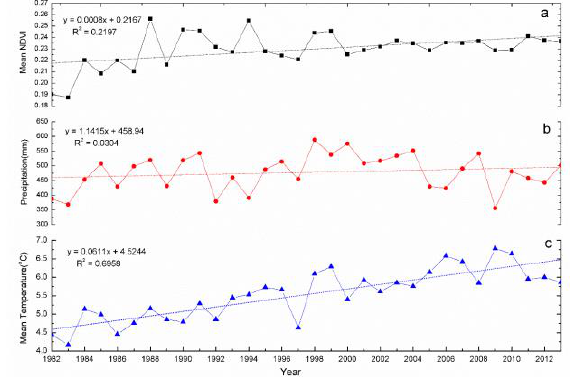
Figure 4. Changes of annual NDVI, precipitation and temperature from 1982 to 2013 in the Yalung Zangbo River Basin